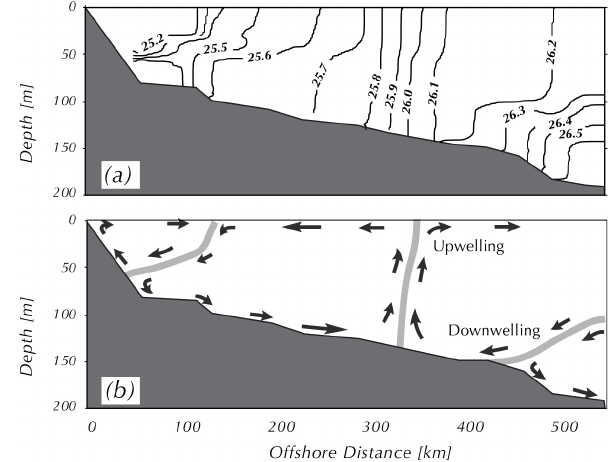
Fig. 11. Density cross-shelf section off Grande Bay ( ∼ 51 ◦ S) from a hydrographic cruise in March 1994 (top panel). Schematic show- ing the fronts identified in this section and the inferred circulation patterns. (After Sabatini et al.,